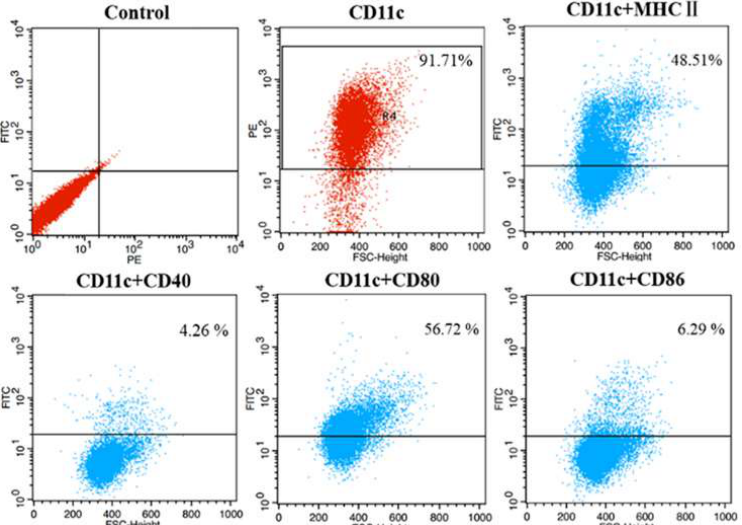
Figure 1. Analysis of cellular surface Ag expression on murine bone marrow derived dendritic cells. The immature dendritic cells (DCs) were defined by expression of the specific surface markers (CD11c, CD40, CD80, CD86 and MHC-II) by flow cytometry.